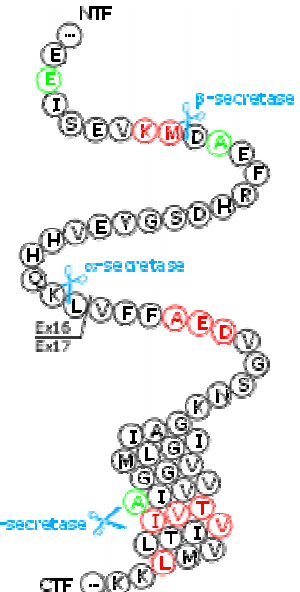
FIGURE 1. Schematic representation of exons 16 and 17 of APP. Amino acids with pathogenic missense mutations are shown in red and amino acids with not-pathogenic missense mutations are in green. For each mutation a hyperlink to the AD mutation database (http://molgen-www.uia.ac.be/ADMutations/) is